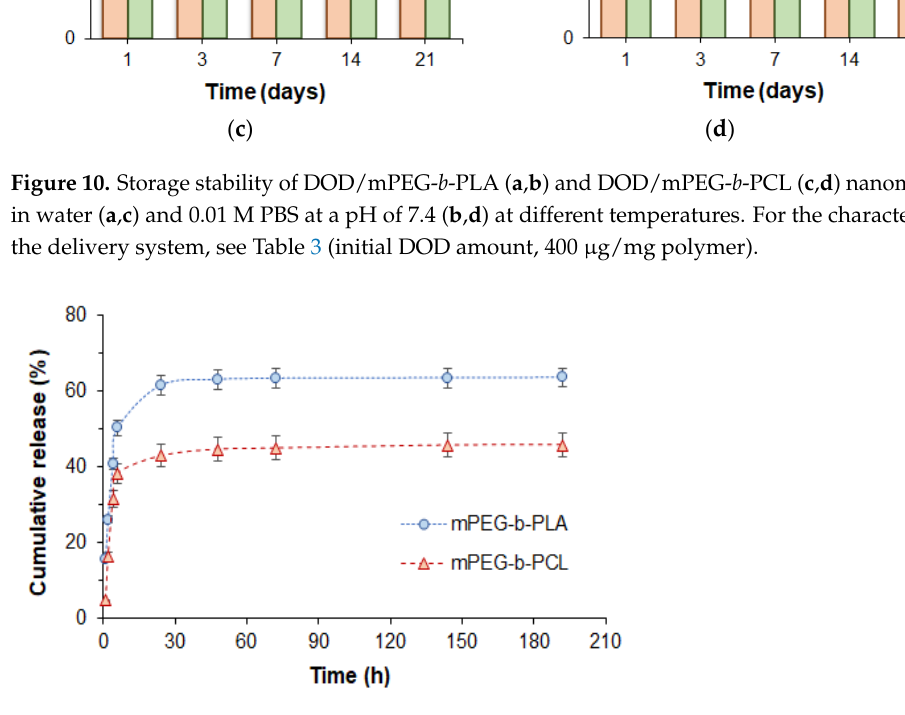
Figure 11. Profiles of DOD release from mPEG-b-PLA and mPEG-b-PCL (0.01 M PBS, pH 7.4).